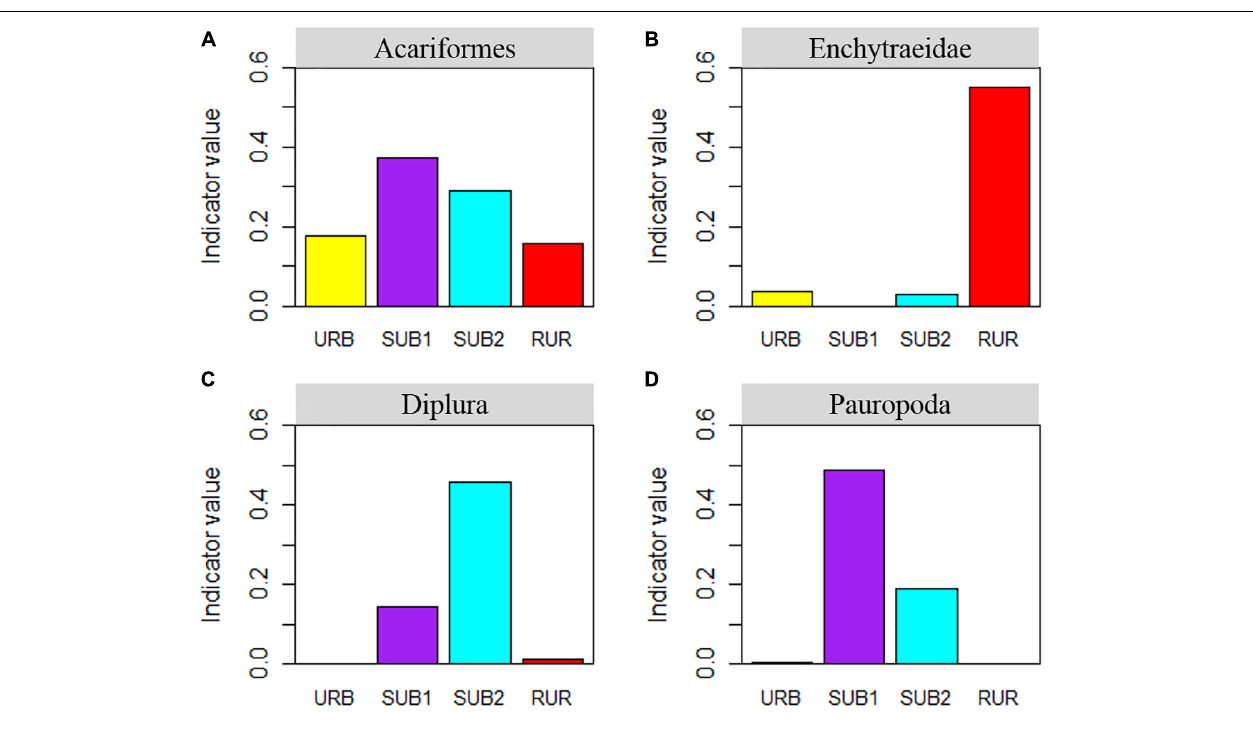
FIGURE 6 | Significant indicator taxa for each urbanization gradient site as determined by the Dufrene-Legendre indicator species analysis. The significant indicator taxa are (A) Acariformes, (B) Enchytaeidae, (C) Diplura, (D) Pauropoda. The urbanization gradient sites are urban (URB), suburban 1 (SUB1), suburban 2 (SUB2), and rural (RUR)